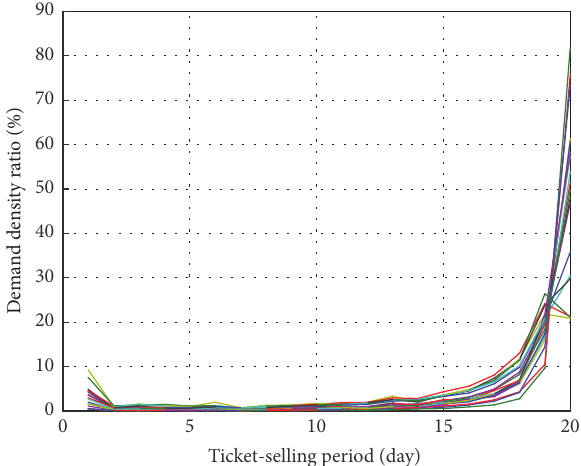
Figure 2: The demand density ratio of each day by O-D.